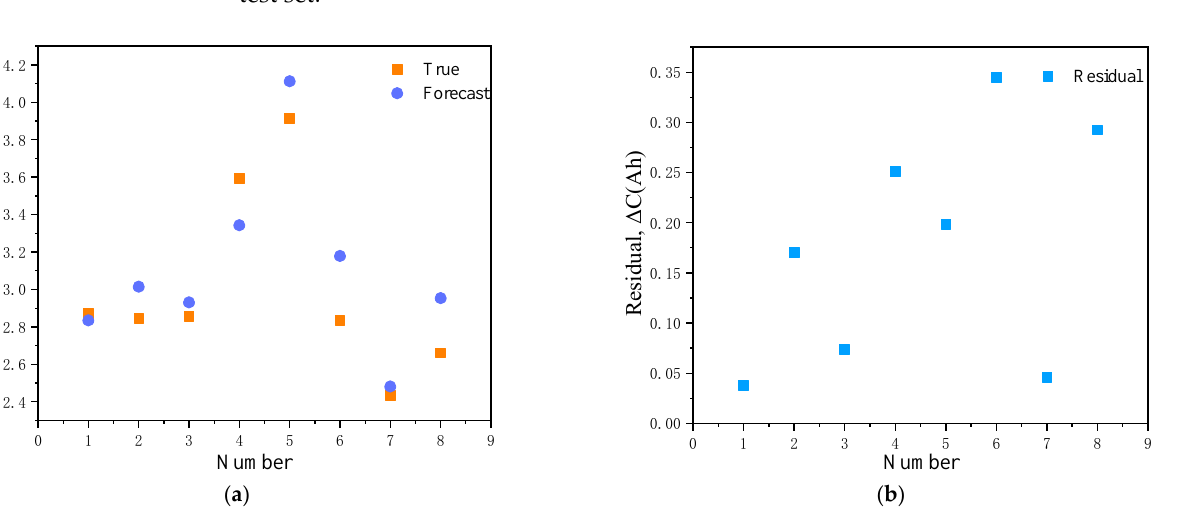
Figure 7. Prediction of R-N6 battery discharge capacity. ( a ) The distribution of true and forecast values; ( b ) the distribution of residuals.